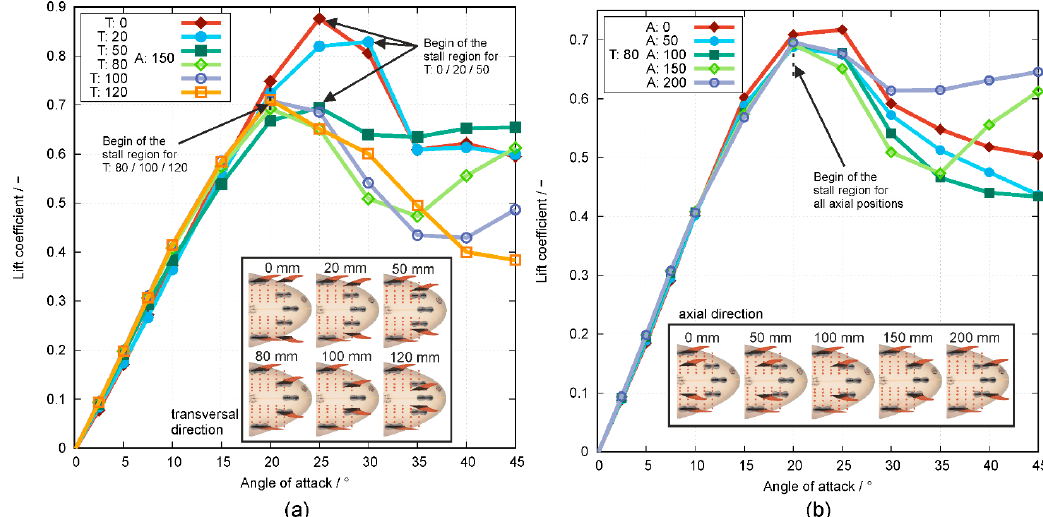
Figure 14. ( a ) Mean lift coefficients versus the angle of attack for six entire fin configurations. The rear fins are fixed in one axial position and shifted for six positions of the transversal direction of the surfboard. ( b ) The mean lift coefficients versus the angle of attack for five entire fin configurations. The rear fins are fixed in one transversal position and shifted for five positions of the axial direction of the surfboard. C D : Figure 15 presents the mean drag coefficients C D of the entire 4-fin configurations versus the